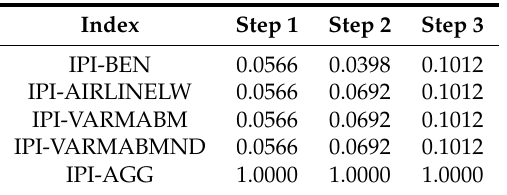
Table 35. Model confidence set hierarchy loss function is squared error at the end of the sample α = 0.05, number of bootstrap replications = 5000 and block length =